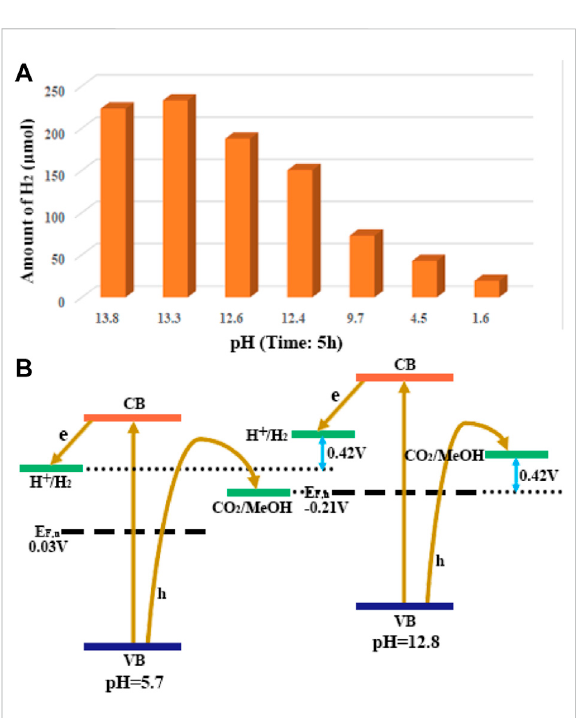
FIGURE 2 (A) the relationship of pH values to the ef fi ciencies of H 2 evolution with g-C 3 N 4 photolysis; (B) energy diagrams of g-C 3 N 4 in solution at pH 5.7 and 12.8.